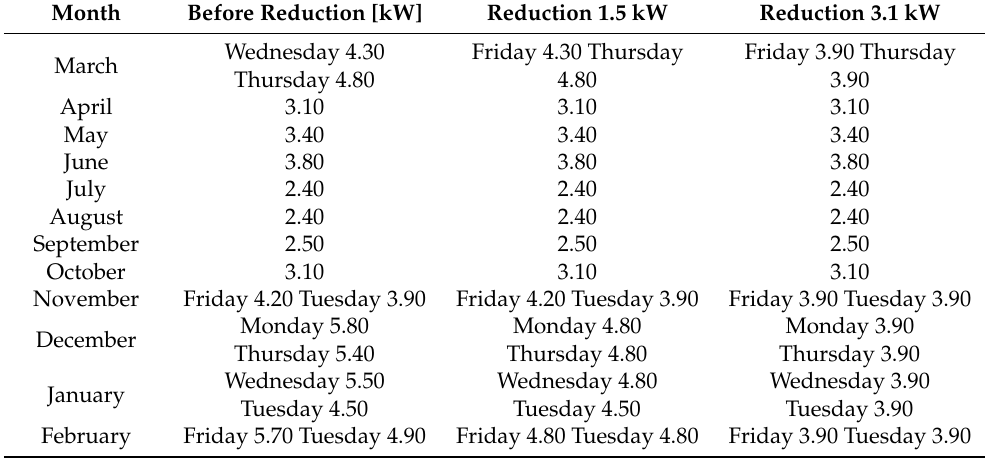
Table 4. Maximum power output before and after reduction of the power peak for low power